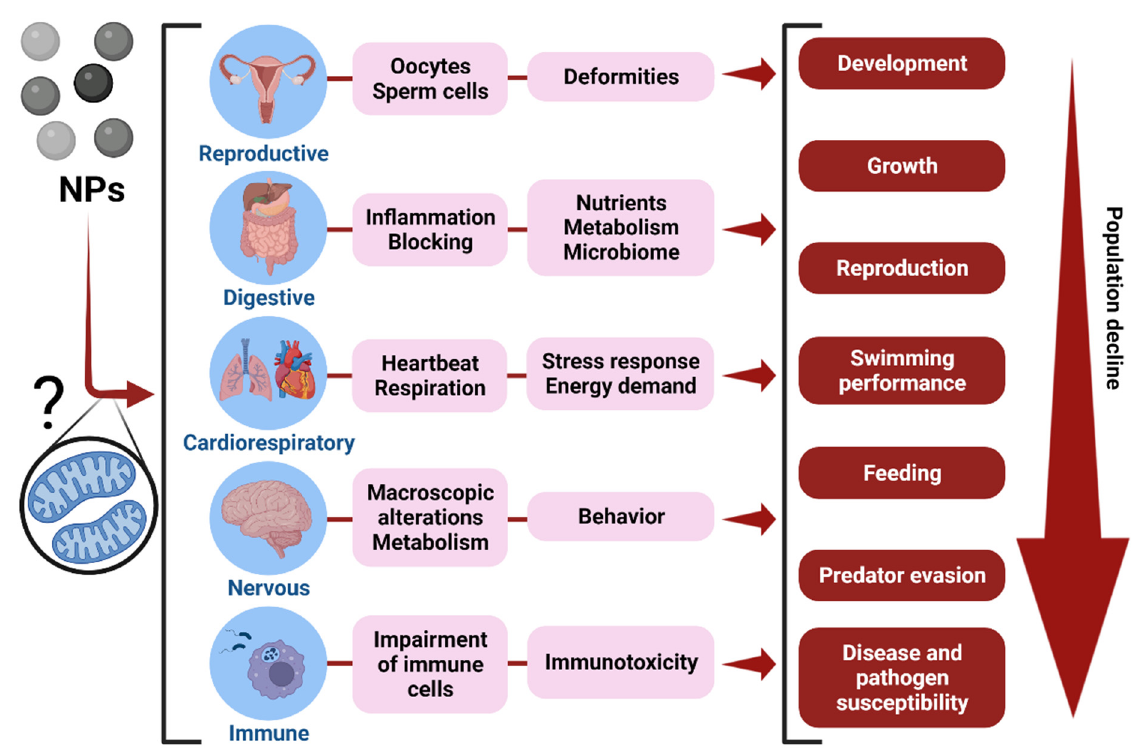
Figure 2. Potential cellular and physiological impacts of nanoplastics (NPs) on aquatic organisms. NPs may accumulate in tissues associated with various physiological systems (blue), prompting intracellular processes (light red) that can influence animal physiology (dark red). Mitochondrial biology and metabolism are commonly affected by NPs, which may mediate some of the major cellular and physiological effects of NPs, although there is a major research gap surrounding this topic. For representative purposes, the figure does not illustrate how specific types or concentrations of NPs will differentially affect the animal at the subcellular, cellular, or physiological levels. Organs are shown as corresponding to mammalian species for purposes of visualization